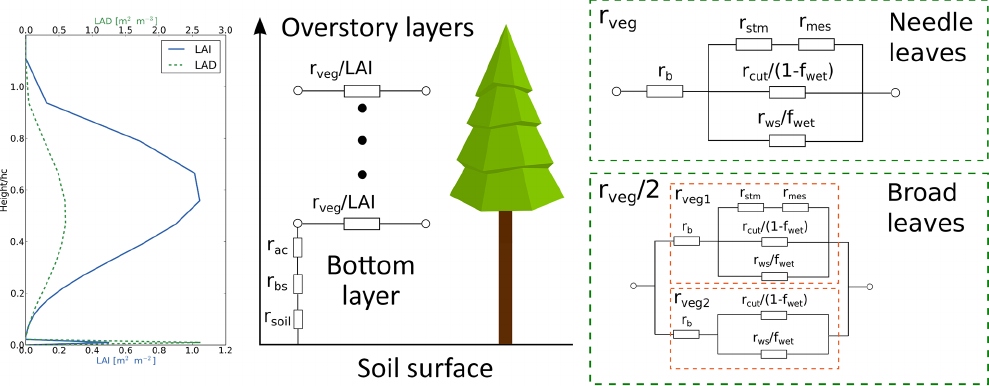
Figure 1. Vertical profiles of all-sided LAI (leaf area index) and LAD (leaf area density), as well as the diagram of resistance analogy method used in the O 3 dry deposition model. The overstorey layers and the bottom layer are considered separately. The bottom layer includes the broad-leaved understorey vegetation and soil surface. r ac is the resistance representing the turbulent transport from the reference height of the understorey vegetation to the soil surface. r bs is the soil boundary layer resistance. r soil is the soil resistance. r b is the quasi-laminar boundary layer resistance above the leaf surface. r veg represents the resistance to vegetation leaves, which is plotted on the right-hand side in detail. For broad leaves, the resistance to the side with ( r veg1 ) or without ( r veg2 ) stomata is computed separately. r stm is the stomatal resistance and r mes is the mesophyllic resistance. r cut is the cuticle resistance and r ws is the resistance to wet skin. f wet is the wet skin fraction. All the variables are defined for each layer. Note that here LAI is the all-sided leaf area index for each layer. The symbols are also explained in the text and Table